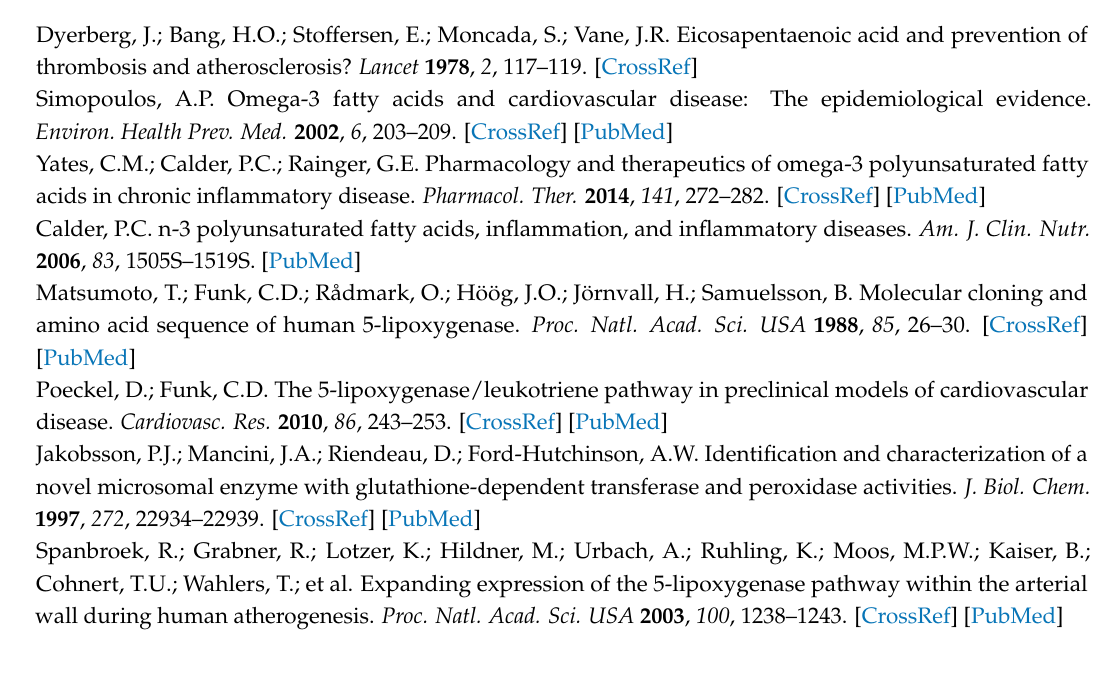
Figure S1: Gene expression of Malic enzyme 1 (ME1) and thioredoxin reductase 1 (TXNRD1) in HUVECs treated with eicosanoids for 6